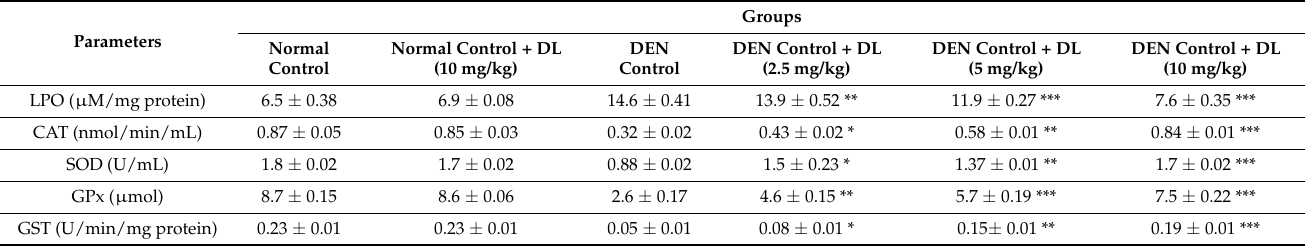
Table 5. Effect of DL on endogenous antioxidant markers.